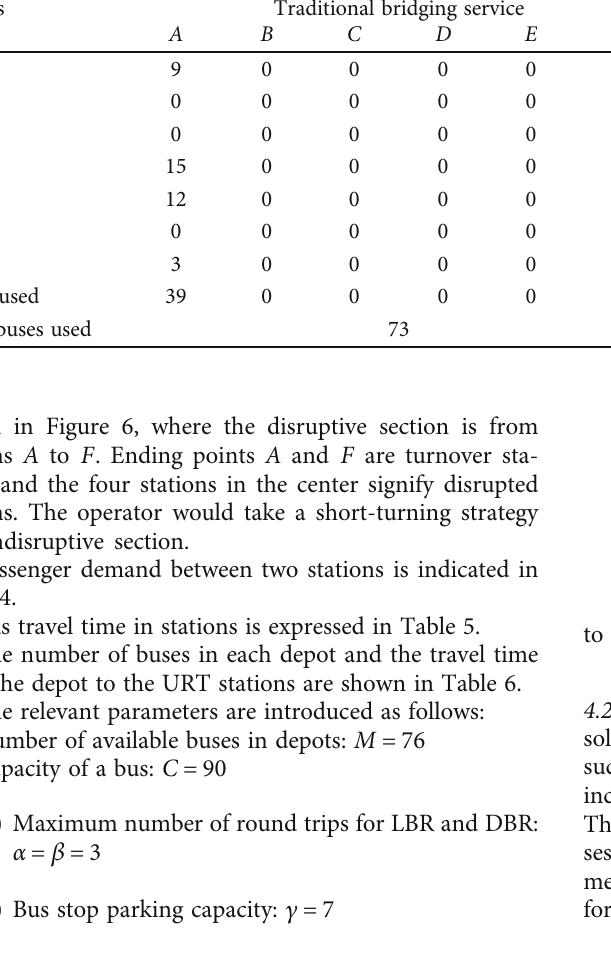
Table 8: Comparative results of the optimization bridging service and traditional bridging service.